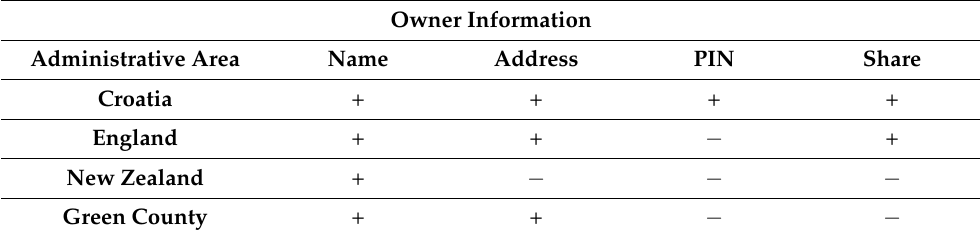
Table 3. Attribute analysis of Register’s owner